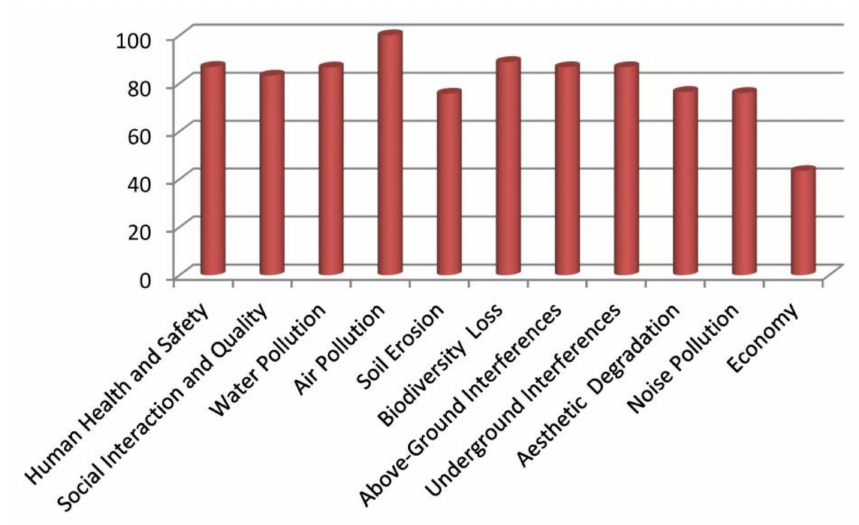
Figure 5. Final weighted impact scores of Sindh Engro coal